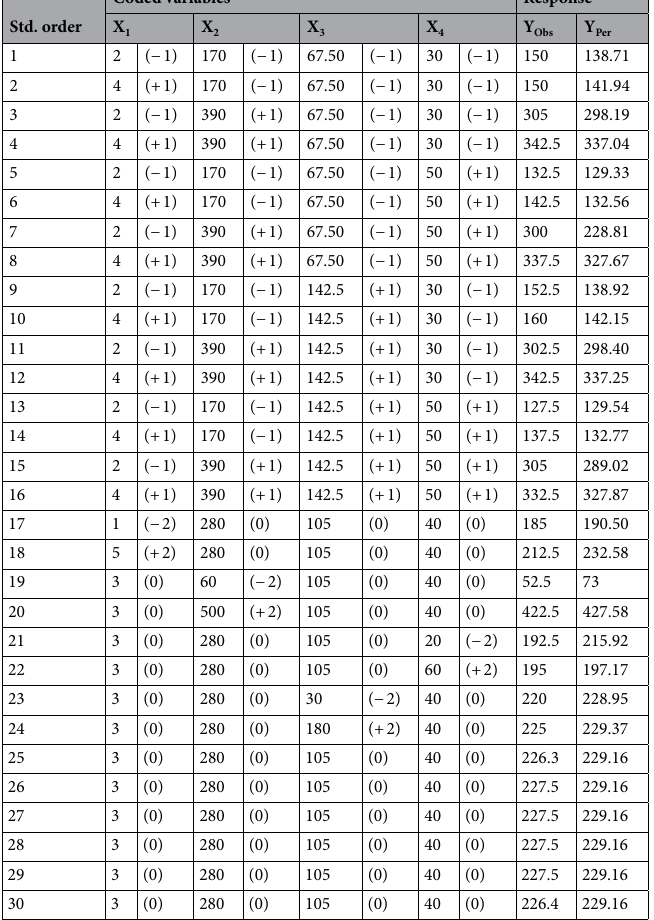
Table 6. Analysis of variance (ANOVA) for response surface quadratic model of Cu(II) elimination using GFLE nanocomposite. R 2 = 0.9883; Adj R 2 = 0.9839, Pred R 2 = 0.9560, Coefficient of variance = 4.64%. a p < 0.01, highly significant; 0.01 < p < 0.05 significant; p > 0.05, not significant.